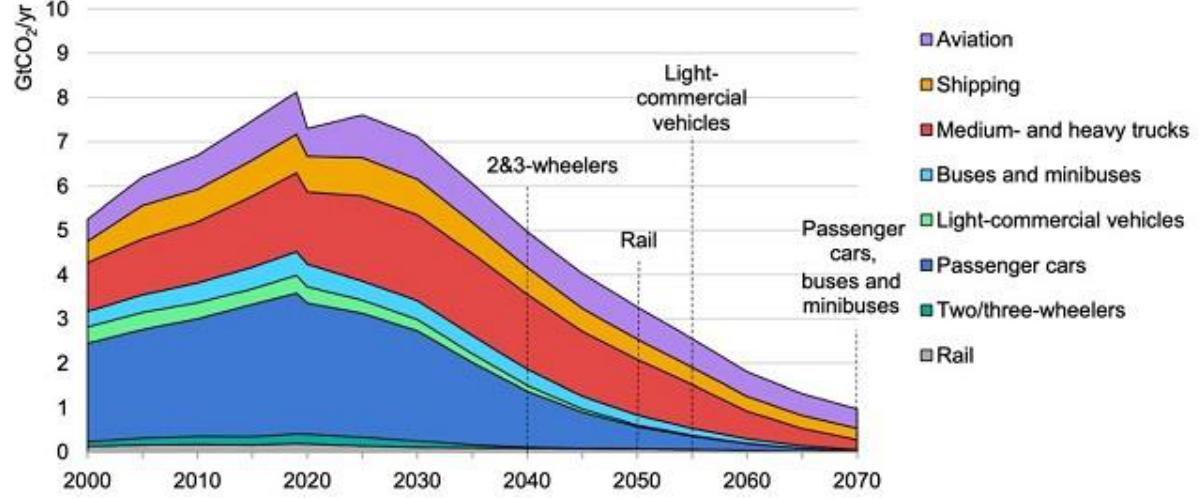
Fig. 1. CO 2 world emitters estimated input 2000-2070 (Source: Energy Technology Perspectives,